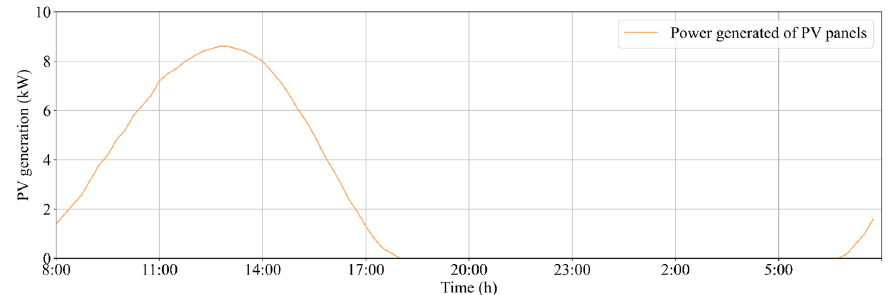
Figure 5. Energy generation of the PV panels.